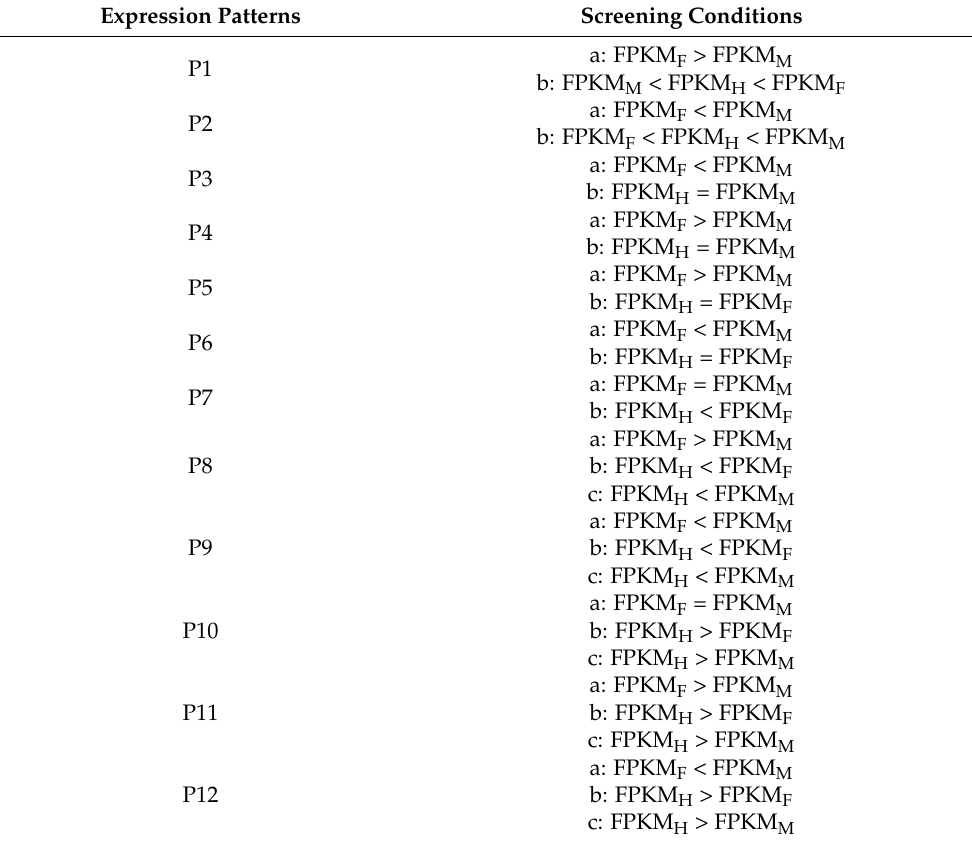
Table 5. Screening conditions for different expression